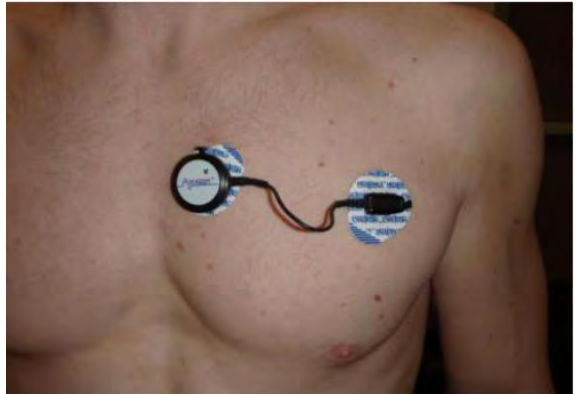
Figure 1. Actiheart set-up (18) Results